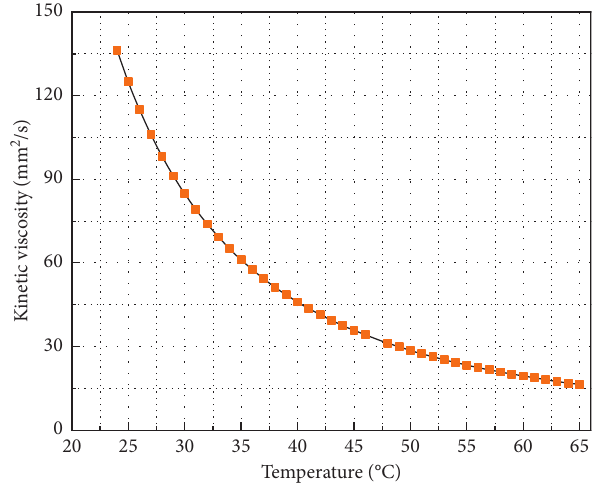
Figure 13: L-HM46 hydraulic oil viscosity variation with temperature. Table 4: Variation ranges of the four different factors. Factors Variation